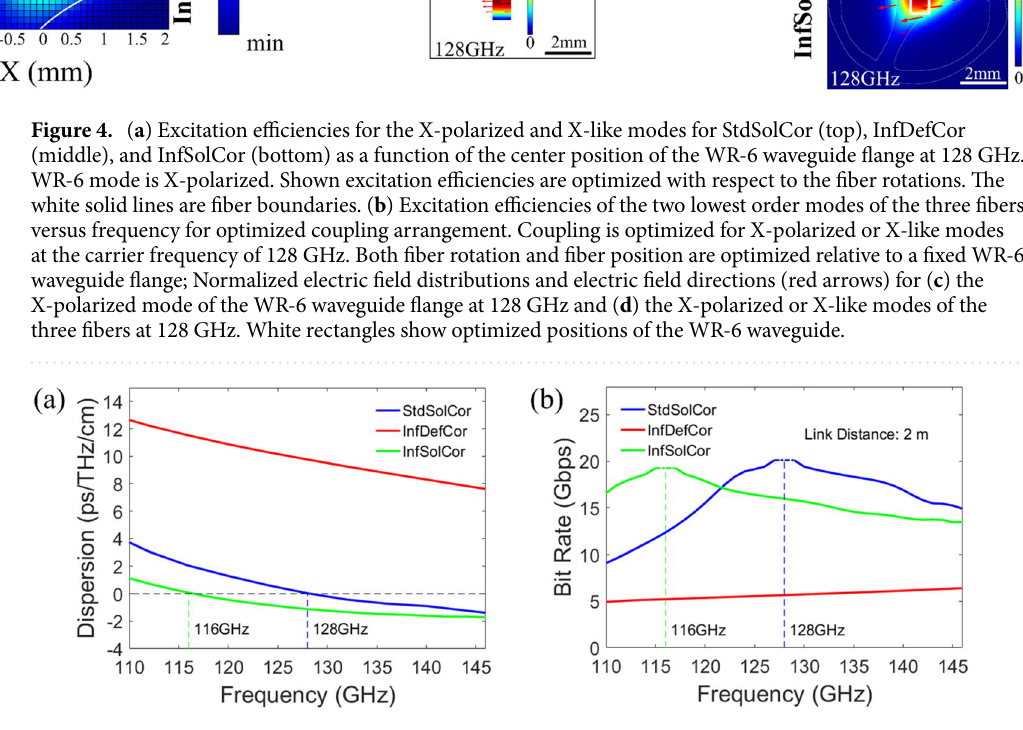
Figure 5. ( a ) Second-order dispersion of the X-polarized and X-like modes versus frequency for the three fibers. ( b ) Maximum bit rate supported by the three fibers for a link length of 2